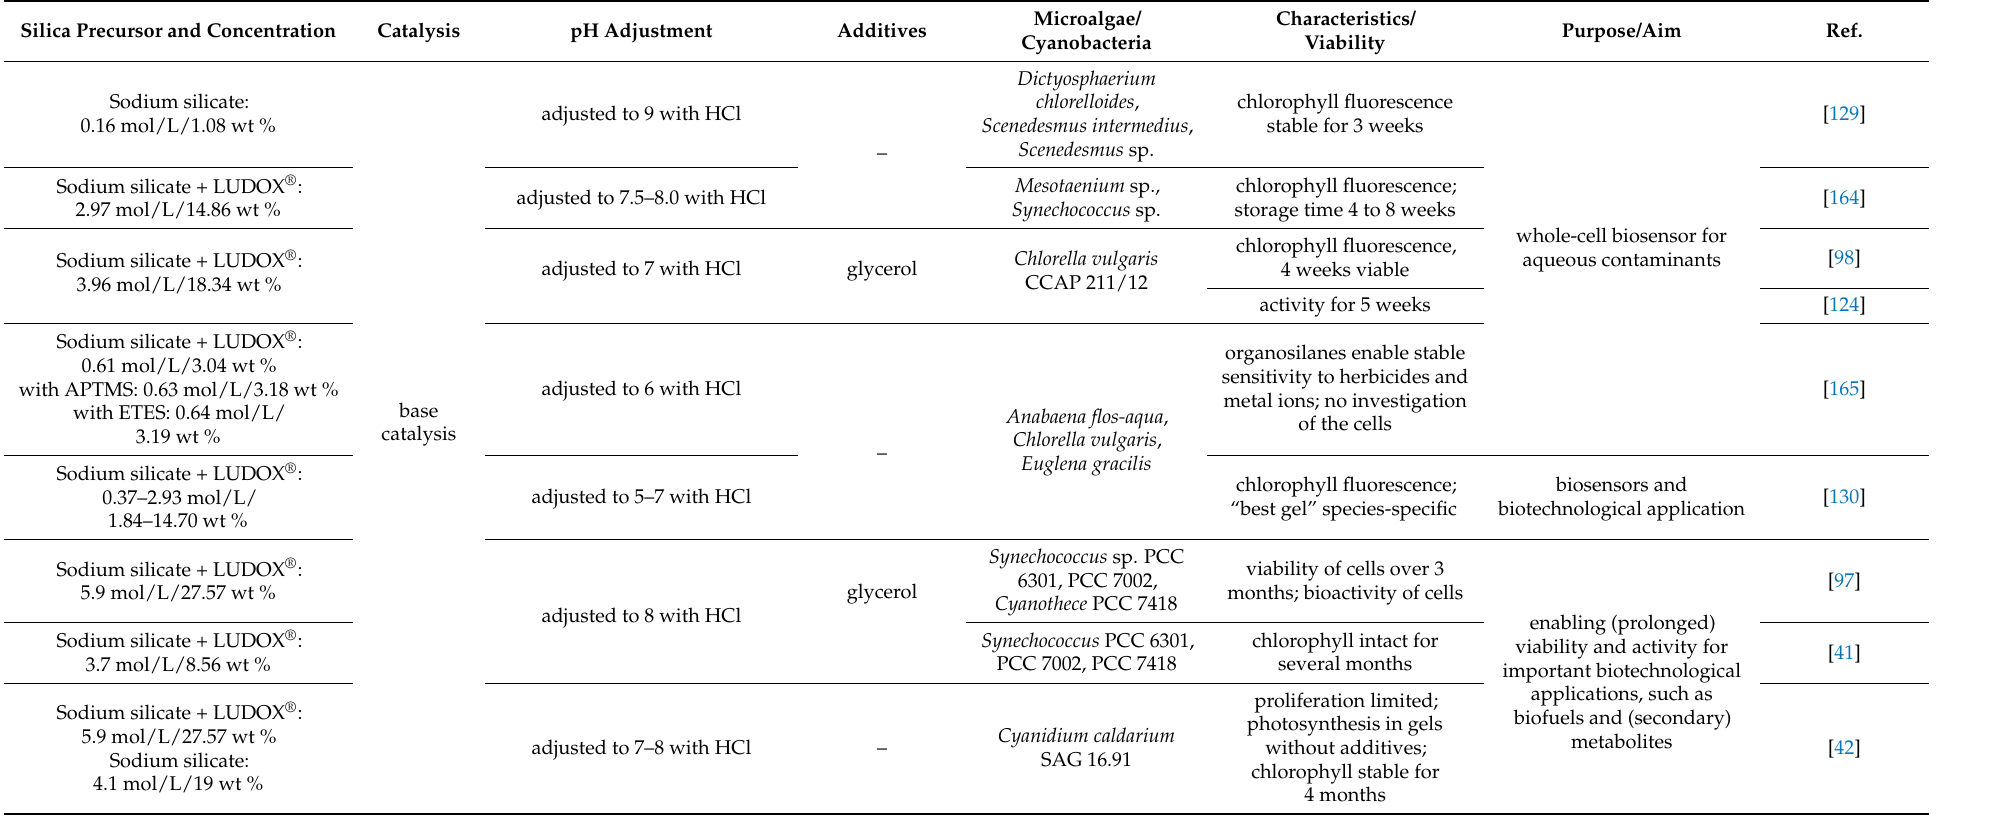
Table 2. Overview of microalgae entrapment in aqueous silicates. APTMS: aminopropyl trimethoxysilane; ETES: